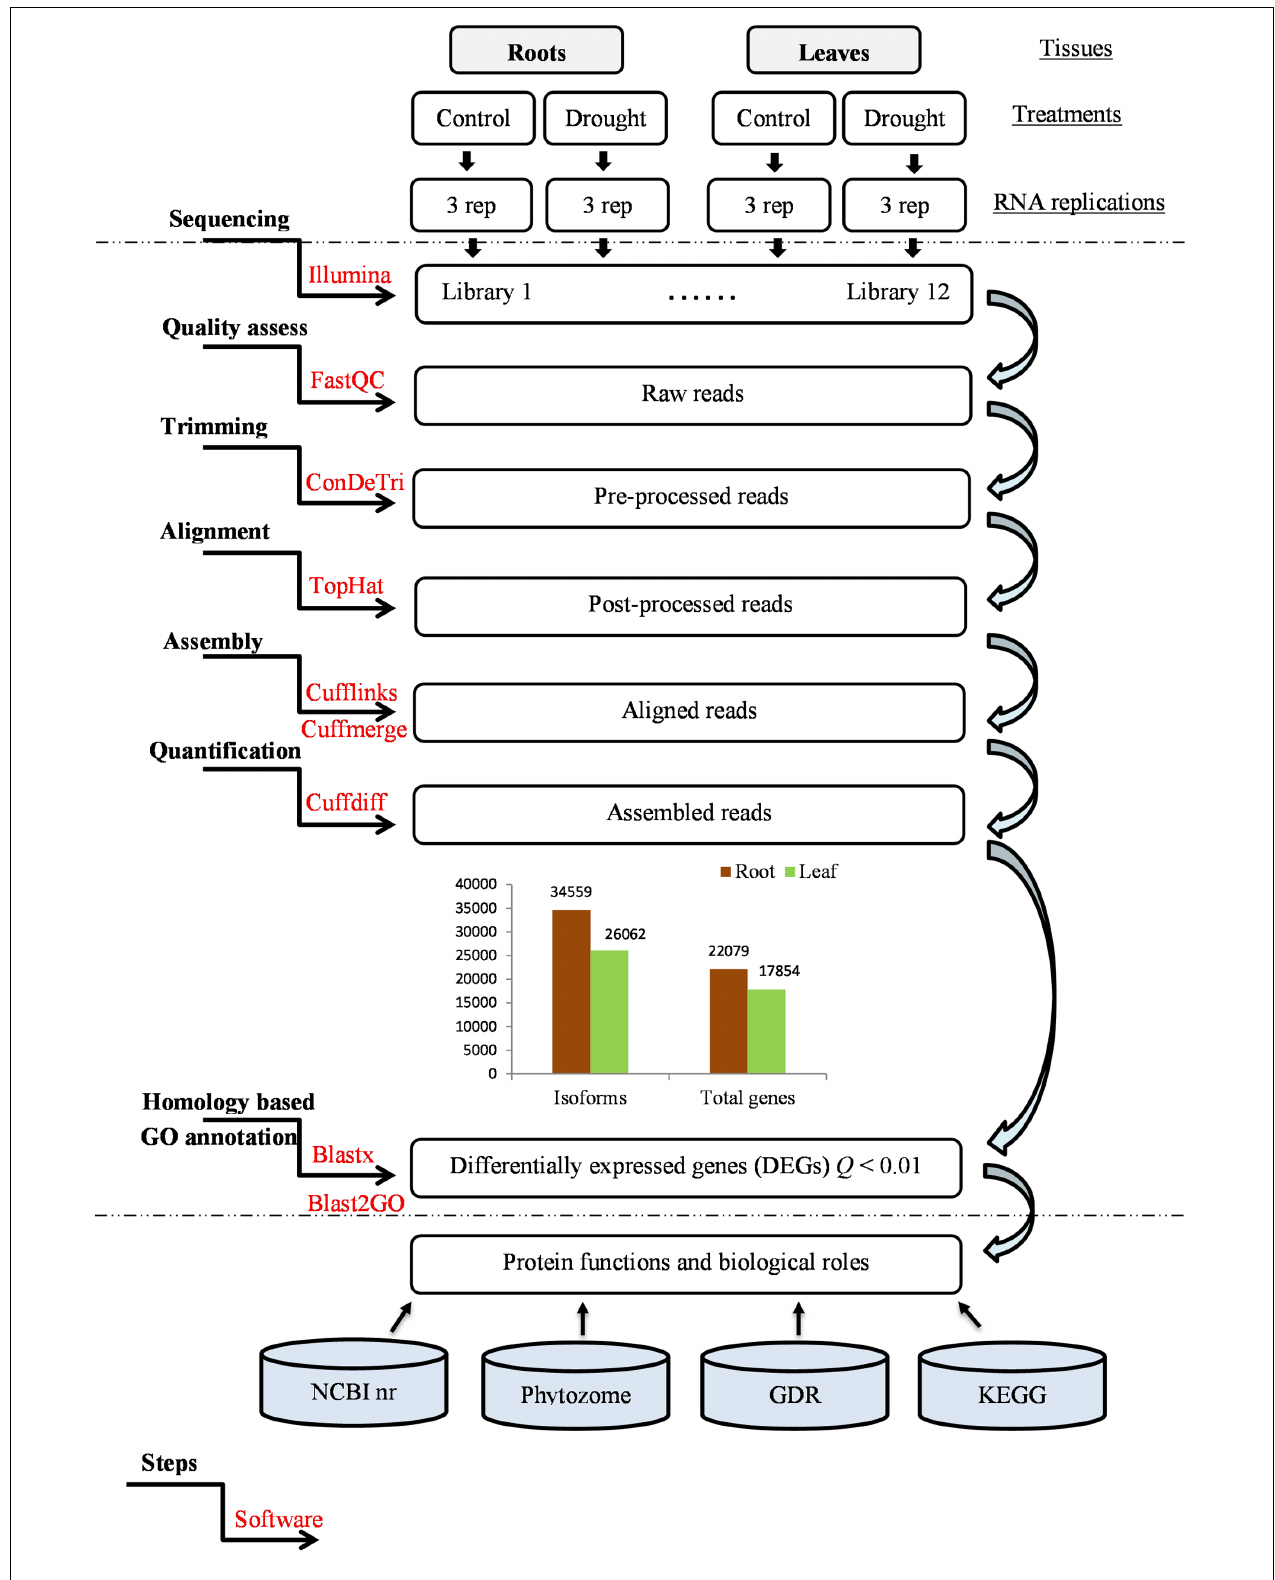
FIGURE 1 | RNA-seq